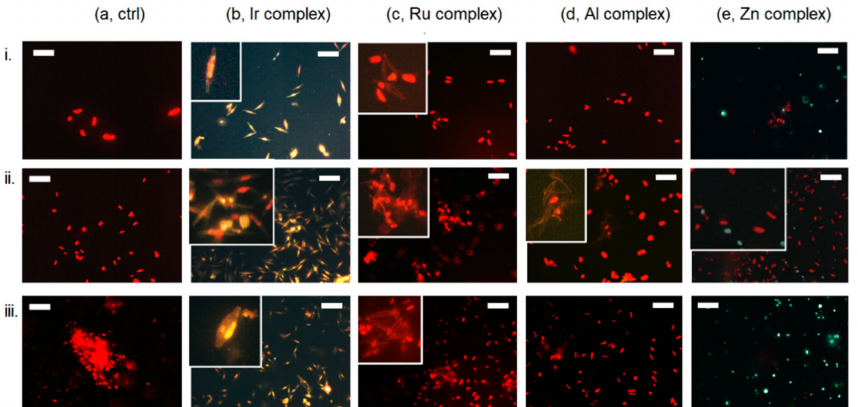
Figure 3. Bidimensional fluorescence microscopy images (in merge mode) of Phaeodactylum tricornutum ( Ph. tricornutum) cells in ( a ) the control sample and after addition of ( b ) [Ir(ppy) 2 bpy] + , ( c ) [Ru(bpy) 3 ] 2+ , ( d ) AlQ 3 , and ( e ) ZnQ 2 . Fluo- rescence micrographs were acquired using red channel ( λ exc = 540 nm, λ emi > 590 nm) for chloroplasts and Ru-complex emission, DAPI-channel ( λ exc = 365 nm, λ emi ≥ 445 nm) for Ir-emission, and a combination of DAPI-channel and FITC filter ( λ exc = 465 nm, λ emi > 525 nm) for Al- and Zn-emissions. Images are detected after ( i ) 1, ( ii ) 4, and ( iii ) 7 days, and in merge mode when complexes are used. Scale bars: 20 µ m. Insets: magnification focus 2 ×